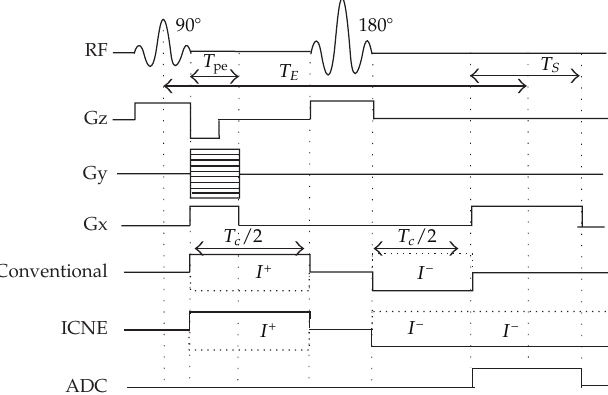
Figure 1: Conventional and ICNE current injections in a spin echo pulse